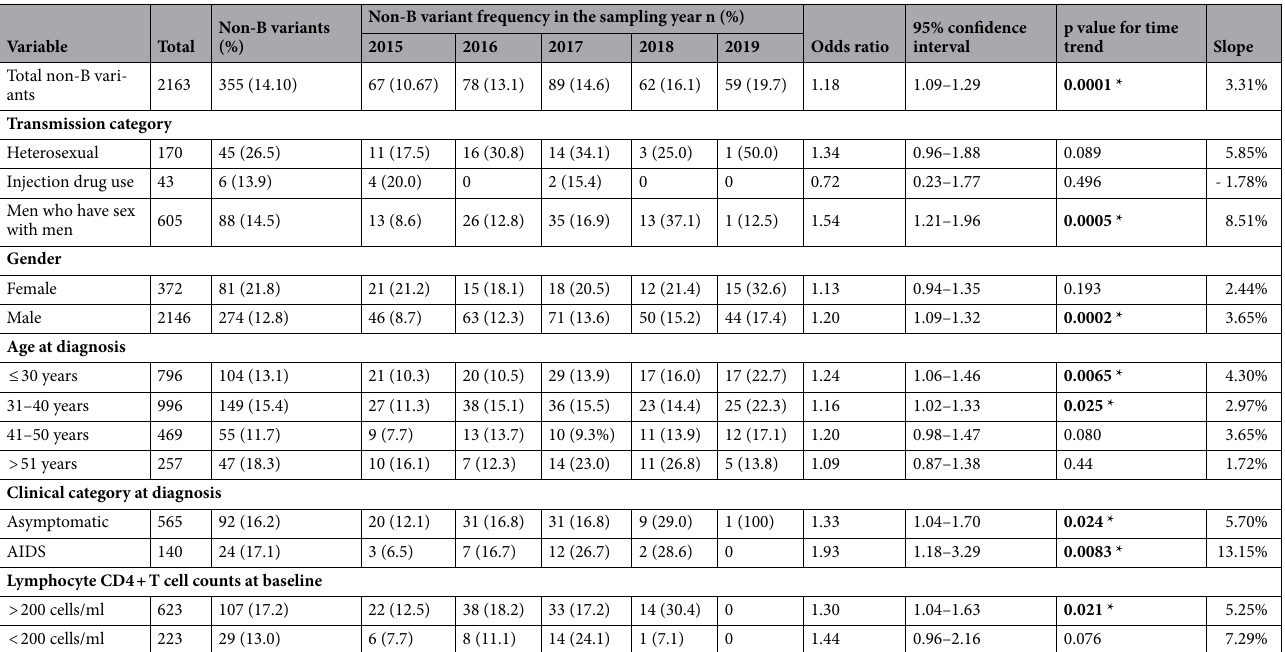
Table 2. Time trends for non-B subtypes across transmission category, gender, clinical category of HIV infection and lymphocyte CD4